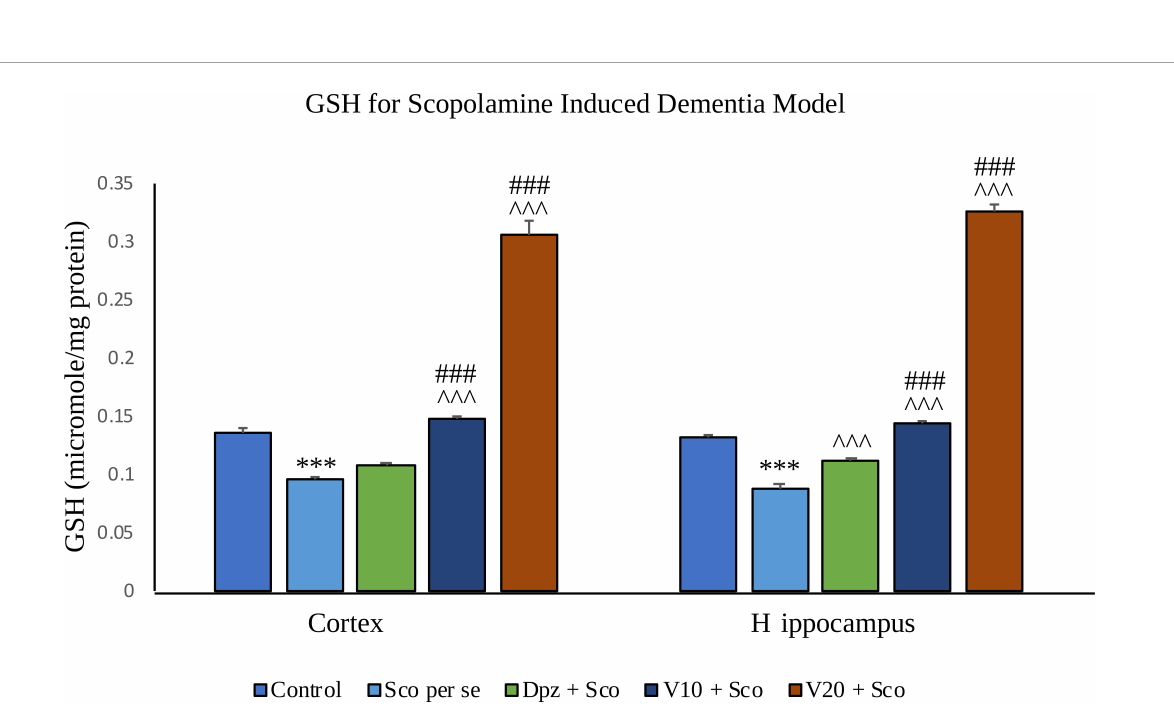
FIGURE19 Effect of vanillin and other treatments on GSH. Data are expressed as mean ± SEM. “***” denotes P < 0.001 with respect to the control group. “###” denotes P < 0.001 with respect to the standard treatment group, and “ ∧∧∧ ” denotes P < 0.001 with respect to the negative control (Sco per se )